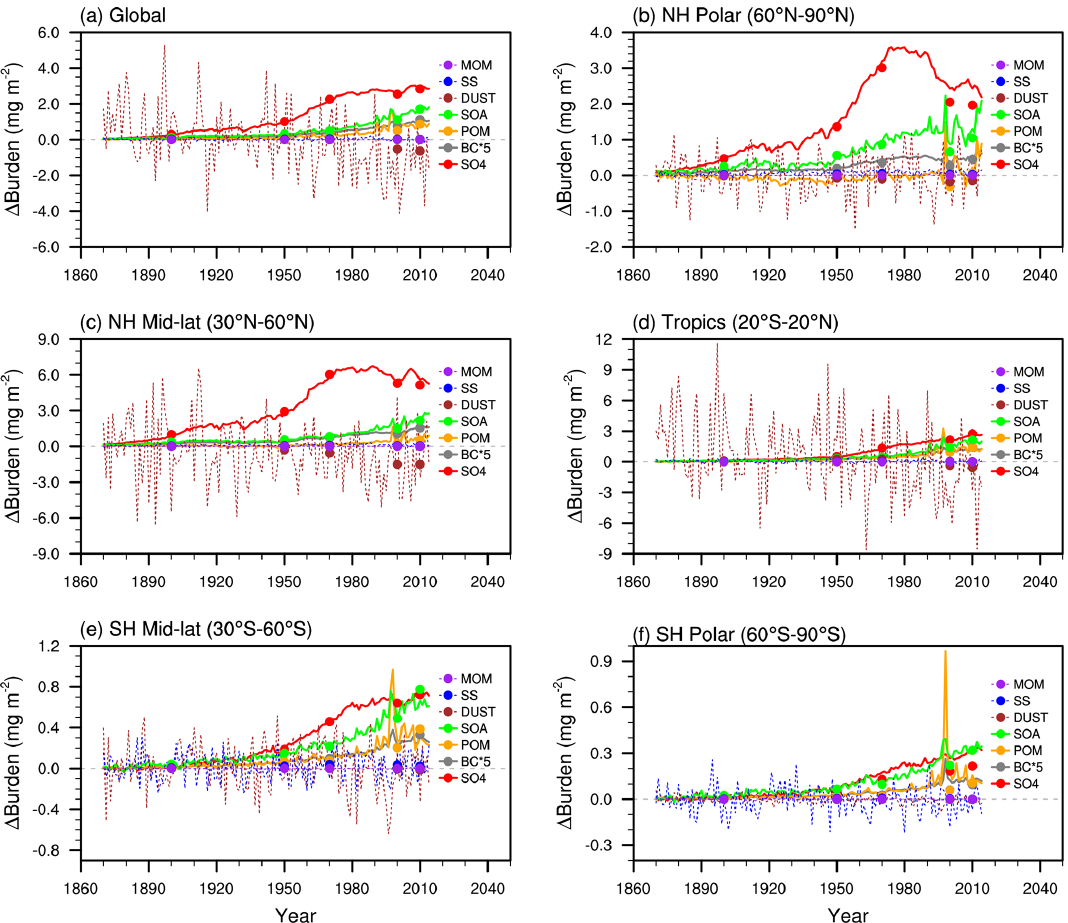
Figure 1. Temporal variations of global and annual mean aerosol burden differences between simulations with transient and pre-industrial (1850) aerosol emissions. Solid lines indicate aerosol species that are directly influenced by anthropogenic aerosol emissions (SO 4 , BC, POM, SOA), and dotted lines indicate natural aerosols (DUST, SS, MOM) that are mainly driven by surface winds. Dots indicate results from the short nudged simulations. Note that for clarity, the BC (cid:49) burden is scaled by a factor of